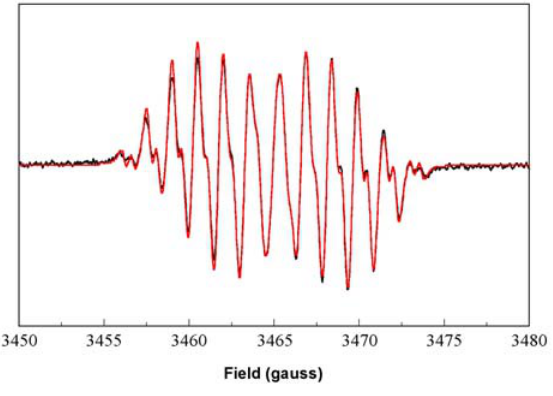
Figure 7. Room temperature ESR spectrum derived from oxidation of 19. Experimental spectrum in toluene at 9.751 GHz (black); simulation (red) with WINSIM [11] using a(H) = 6.37 (1 H), 2.93 (1 H), 1.69 (1 H), 1.59 (1 H), 1.48 (1 H), 1.47 (1 H), 1.40 (1 H), 0.53 G (1